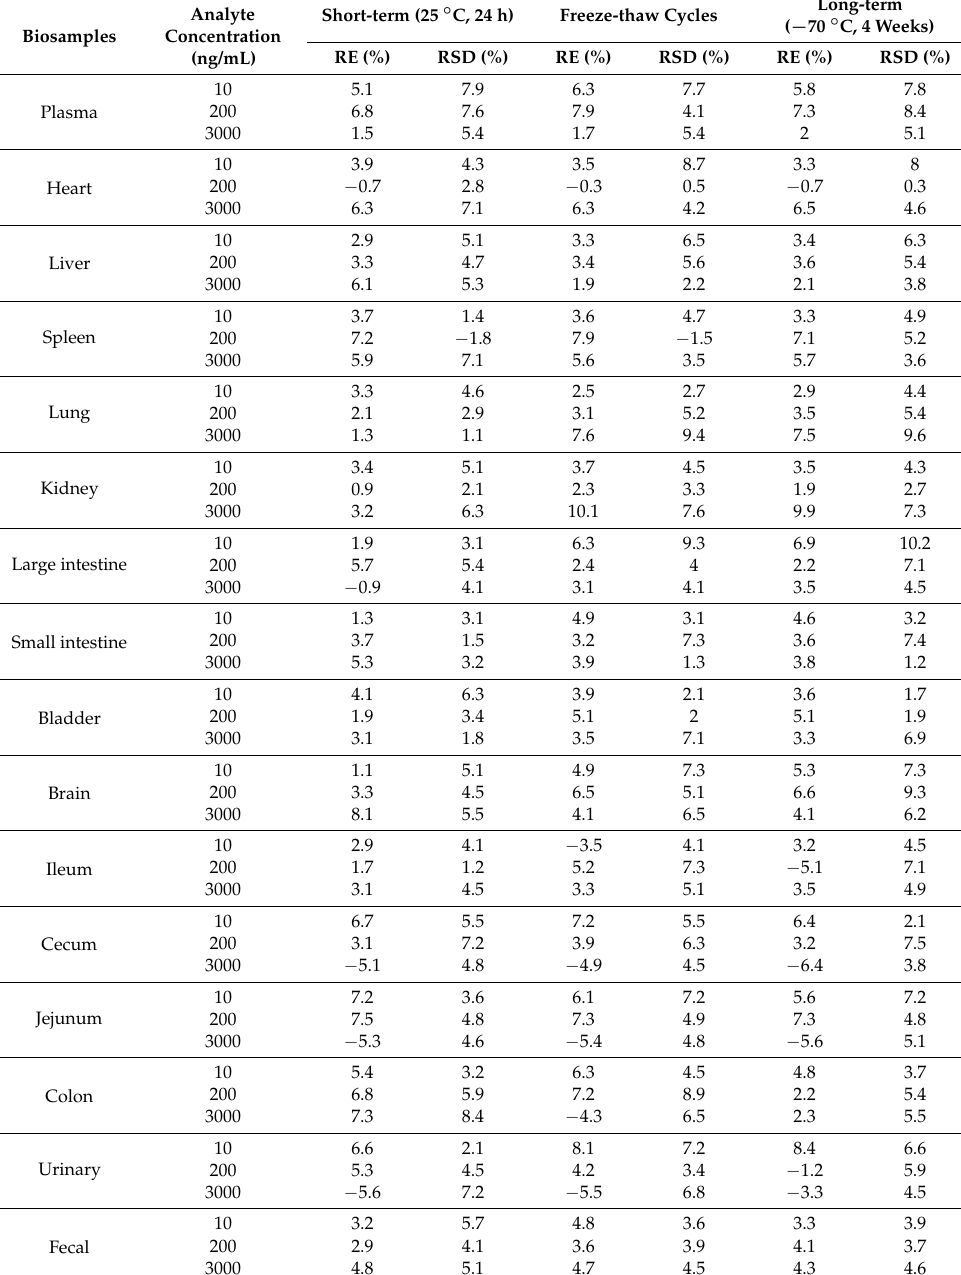
Table 4. Stability of DPTM in plasma, tissue homogenates, urine and